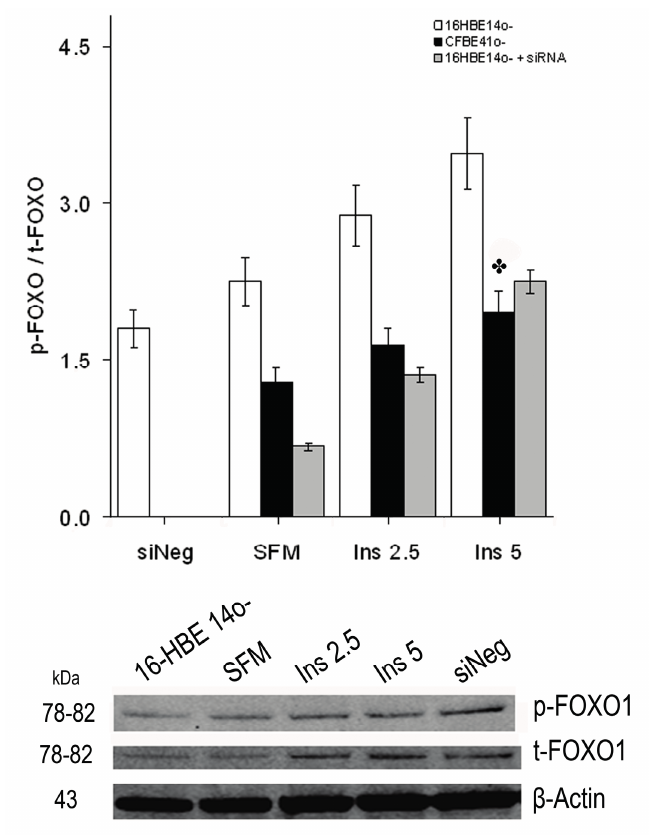
Figure 6. Phosphorylated [S256]/total FOXO1 (p-FOXO1/t-FOXO1) ratio after